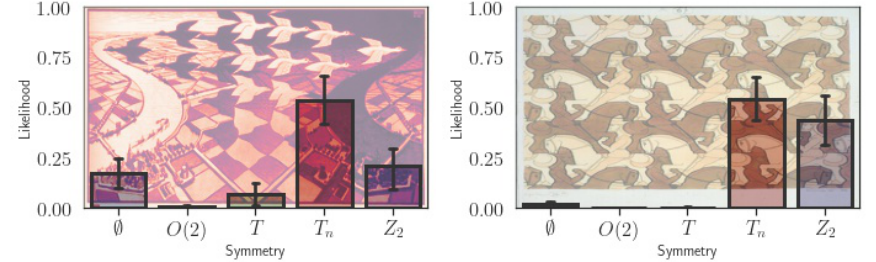
Figure 4: Escher works Night and day and Horseman . The algorithm’s symmetry scores are overlaid on